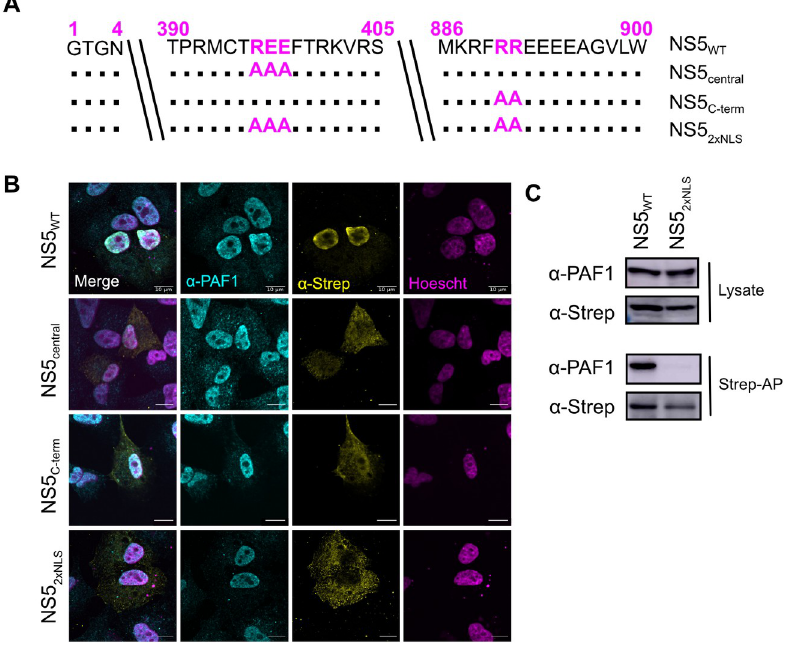
Fig 3. Nuclear localization is required for NS5-PAF1C interaction. (A) NLS mutants, including single mutant NS5 central (REE396-398AAA) and NS5 C-term (RR890-891AA) and the double mutant NS5 2xNLS (REE396-398AAA and RR890-891AA). (B) Subcellular localization of 2xStrep II tagged NS5s (yellow) and colocalization with PAF1 (cyan) was determined by immunostaining and confocal microscopy. Nuclei were stained with Hoechst (magenta). Scale bar represents 10 μ m. (C) The protein interaction between NS5 2xNLS and PAF1 was tested biochemically. Plasmids encoding NS5s and GFP were transfected and affinity purified in HEK293T cells via a 2xStrep II tag. Immunoblot analysis of lysate and purified (Strep-AP) fractions was performed against PAF1, Strep and GAPDH (loading/negative control). Abbreviations: Strep-affinity purified